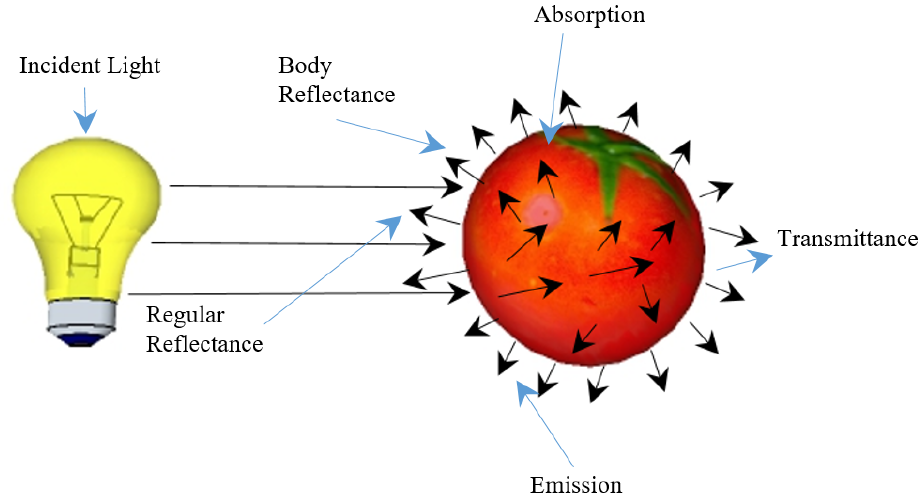
Figure 1. Schematic of the interaction between light and a fruit [5].